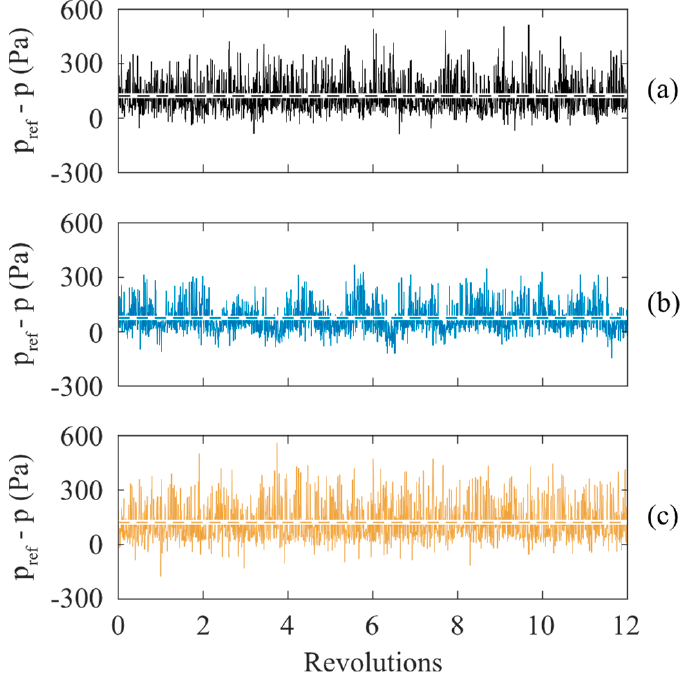
Figure 8. The time history of wall pressures along the BLE at point 2: ( a ) Case 1, ( b ) Case 2, and ( c ) Case 3. The dashed lines indicate the average value for each case.